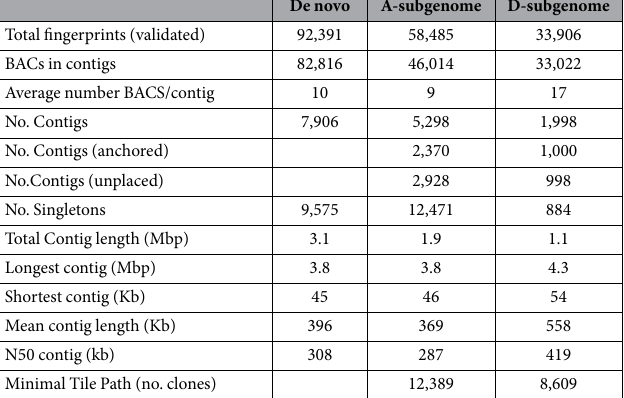
the final validated BAC fingerprint dataset consisted of 90,083 BACs. The restriction-derived BAC set resulted in an average of 122 bands per clone; while the random sheared BACs resulted in an average of 75 bands per clone (Supplementary Table 2). A consensus band (CB) size for the BAC fingerprinting products was estimated to be 1,305 bp, and the collective validated dataset corresponds to ~6X genome coverage, with an estimated haploid G. hirsutum TM-1 genome size of 2.5 Gb. Each fingerprinted BAC was subject to insert end sequencing, which after quality filtering resulted in a total of 179,209 Sanger BAC-end sequence pairs with a mean high-quality read length of 576 bp 21 . These BAC-end sequences account for approximately 0.05X genomic coverage and by integra- tion with the BAC fingerprints serve as sequence anchor points distributed approximately every 12 Kb along the BAC contigs (Supplementary Table 3). Assembly of a de novo physical map, tile path selection, and construction of homoeolog spe- cific pseudomolecules. A de novo genome assembly was performed with the BAC fingerprint dataset using ultra-stringent assembly parameters (see Methods) to group nearly perfect overlapping BACs into contigs with no mismatch band overlaps to avoid cross assembly of homeologous sub genomes. The de novo TM-1 BAC physical map (herein referred to the Physical Mapping Initiative, PI) assembly consists of 92,391 validated BAC finger- prints, of which, 82,816 amassed 7,906 contigs and 9,575 singletons. The total estimated contig assembly length is 3,134 Mb. Contig sizes range from 45 Kb to 3.8 Mb, with a mean contig length of 396 Kb, and an N 50 contig length of 308 Kb (Table 1). The de novo physical map was further integrated with the ~179,000 corresponding BES pairs and aligned to the high-quality G. raimondii (Gr) reference genome assembly 6 for sub genome binning, and subsequent sub genome reassembly and pseudomolecule construction (See Methods). In the PI, the A sub genome of TM-1 assembled as 5,298 BAC contigs that collectively span 1.9 Gb; the contig sizes range from 46 Kb to 3.8 Mb with a mean length of 369 Kb and N 50 of 287 Kb (Table 1). A minimal tile path was selected for the A sub genome that consists of a total of 12,389 clones. The D sub genome of TM-1 assembled as 1,998 BAC contigs that collectively spans approximately 1.1 Gb; the contig sizes range from 54 Kb to 4.3 Mb, with a mean length of 558 Kb and N